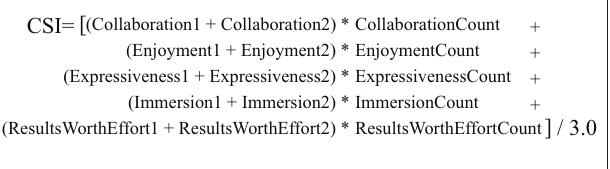
FIGURE 5 | Equation for scoring the CSI (Cherry and Latulipe, 2014).